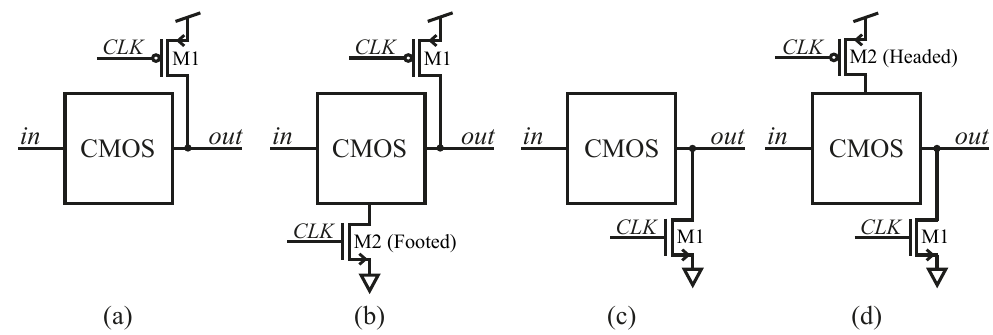
Figure 1. Basic DML gate topologies: ( a ) Type-A logic gate, ( b ) Type-A footed logic gate, ( c ) Type-B logic gate, and ( d ) Type-B Headed logic